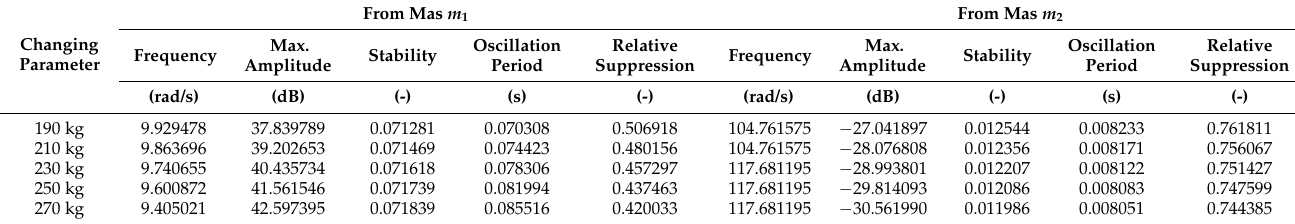
Table 7. The values of the parameters read from the graphs shown in Figure